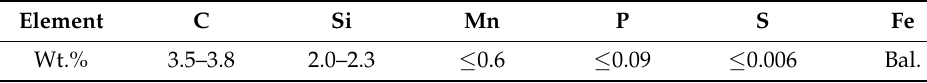
Table 2. Chemical composition of the CGI substrate.